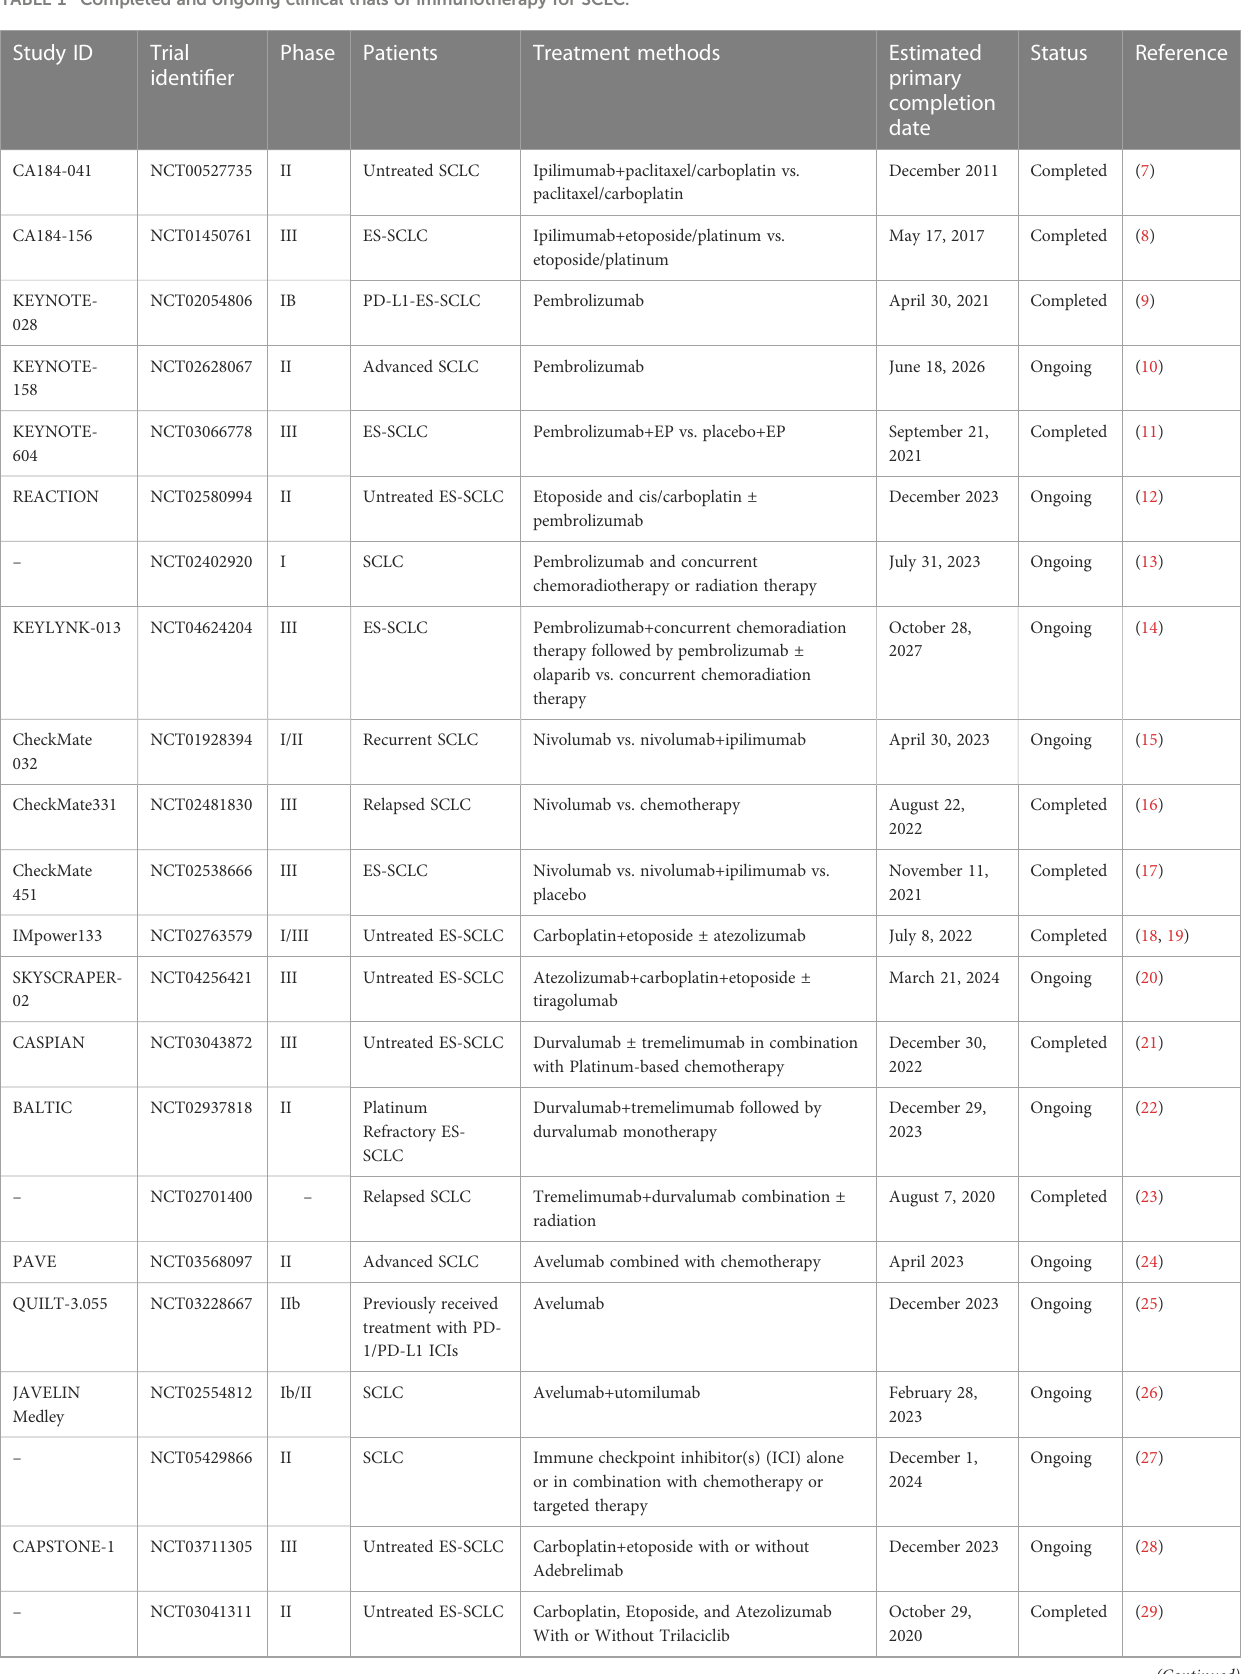
TABLE 1 Completed and ongoing clinical trials of immunotherapy for